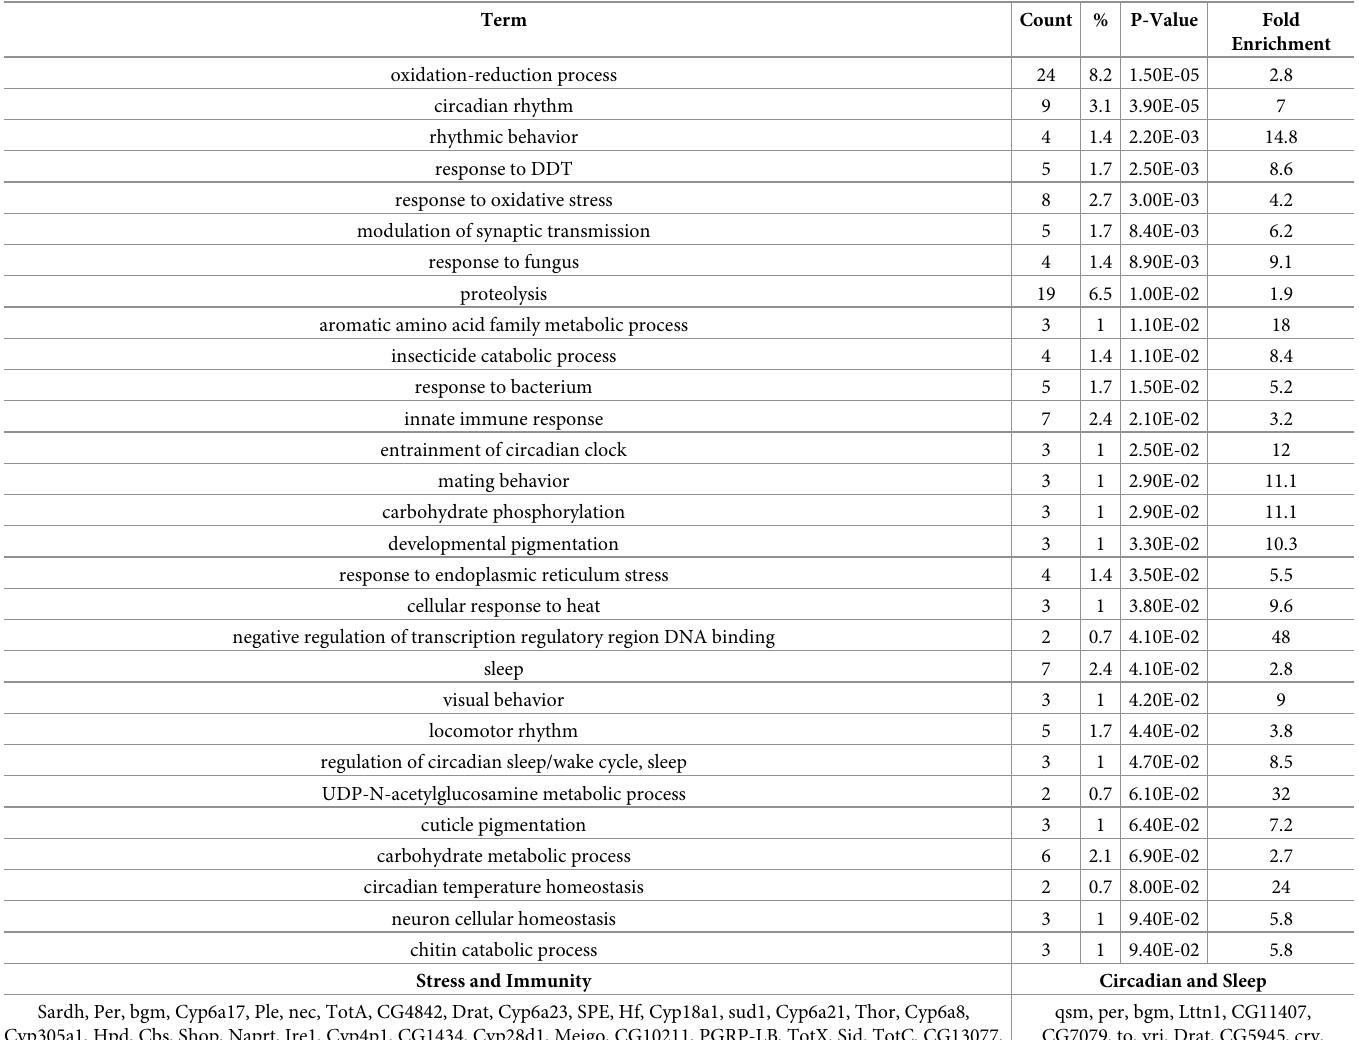
Table 1. Gene Ontology for Enriched Biological